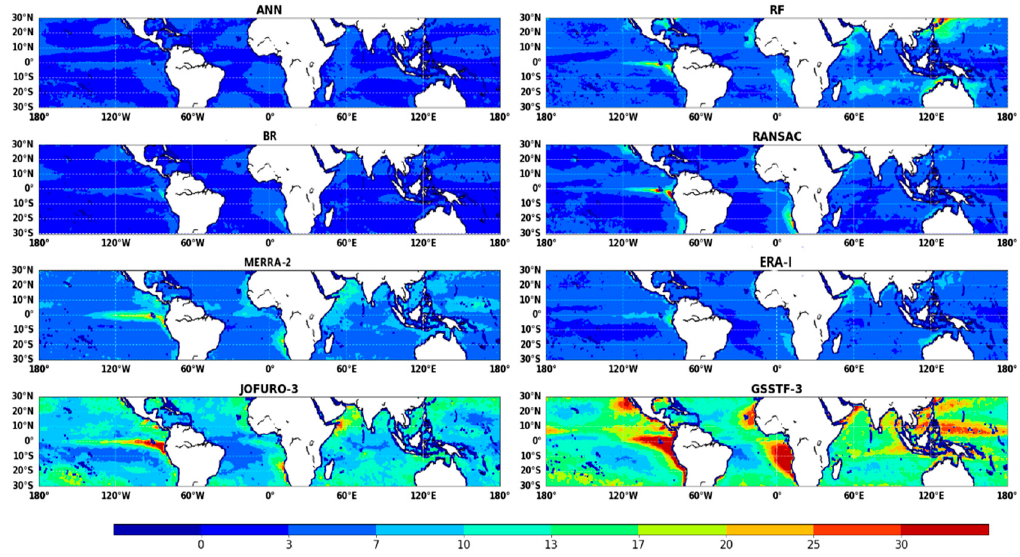
Figure 7. Distribution of relative uncertainties from eight ocean LHF products (including four ocean LHF products and four ensemble LHF products) over low-latitude area (unit W m − 2 ).